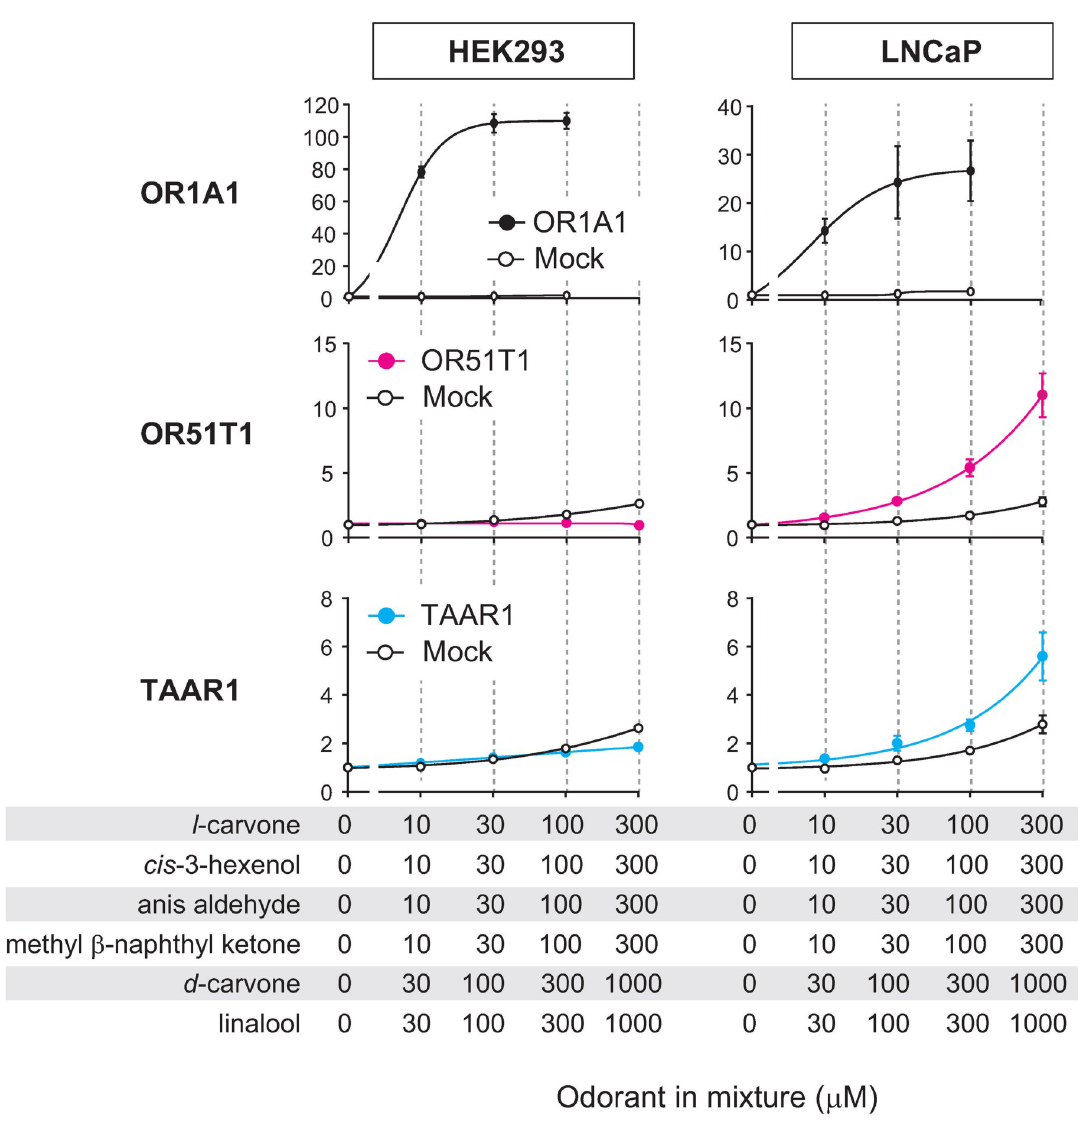
Fig 3. Activations of specific ORs were selectively monitored in LNCaP cells. Dose-response curves of OR1A1 (top, black), OR51T1 (middle, magenta), and TAAR1 (bottom, blue) expressed in HEK293 (left) or LNCaP cells (right) against increasing concentrations of the odorant mixture. Each OR was co-transfected with CRE/luc2PpGL4.29, pRL-CMV, RTP1S and G α olf. X-axis indicates final concentrations of each of the six components of the mixture. Ringer’s solution was used to dissolve the odorant mixture. Assays were also conducted on mock-transfected cells transfected with empty vector, CRE/luc2PpGL4.29, pRL-CMV, RTP1S, and G α olf. (white). Y- axis indicates the fold increase in response. Data are shown as mean ± SE of three independent